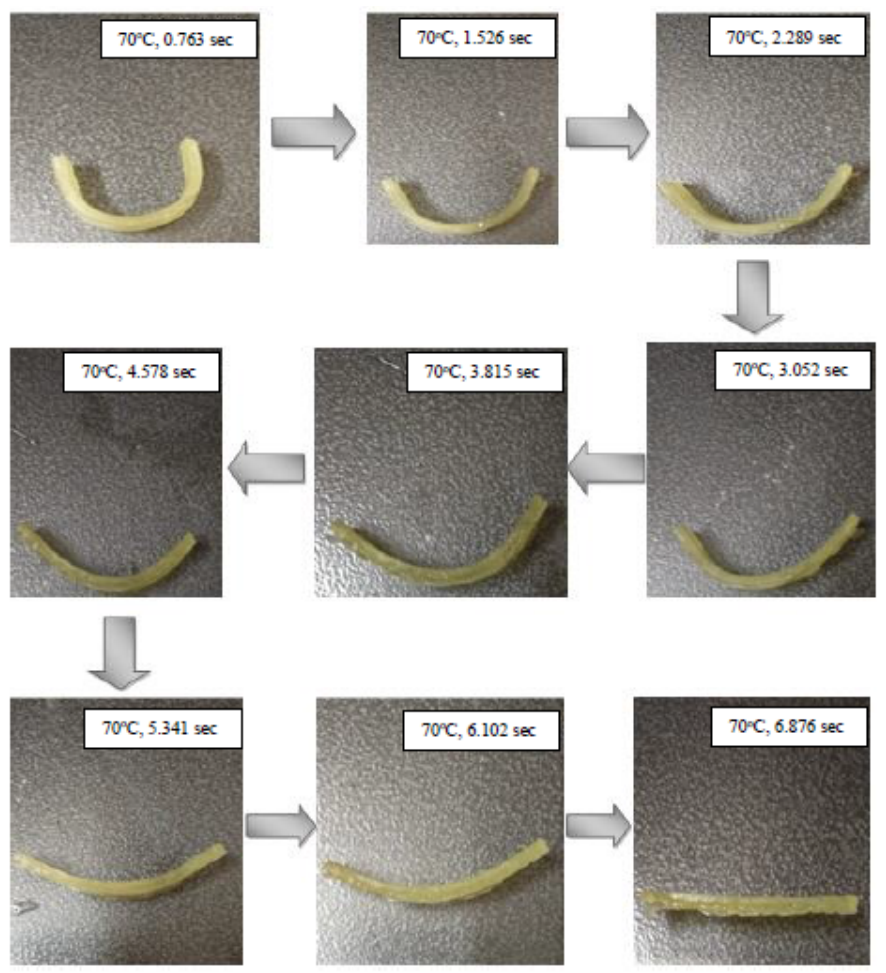
Figure 7. Strain Recovery testing with recovery time and temperature of sample for print speed of 70 mm/s and pulse frequency of 70 pulse/s.